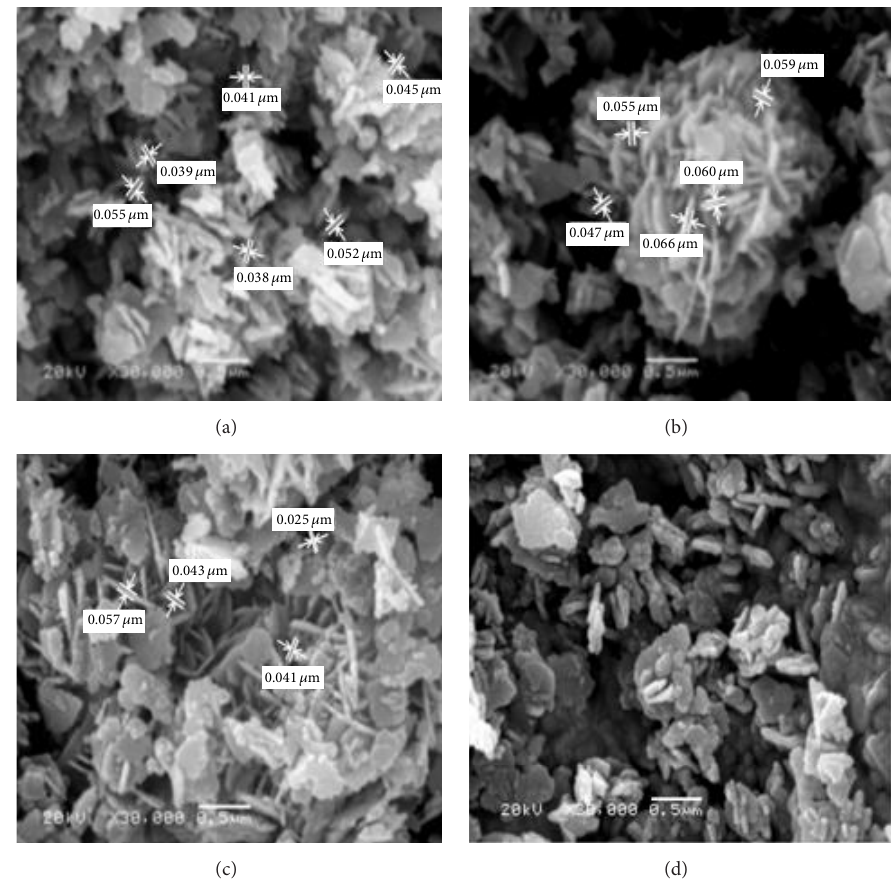
Figure 6: SEM micrographs of ZnO prepared using sol-gel technique at different reaction temperatures: (a) 60 ∘ C, (b) 70 ∘ C, (c) 80 ∘ C, and (d) 90 ∘ C.